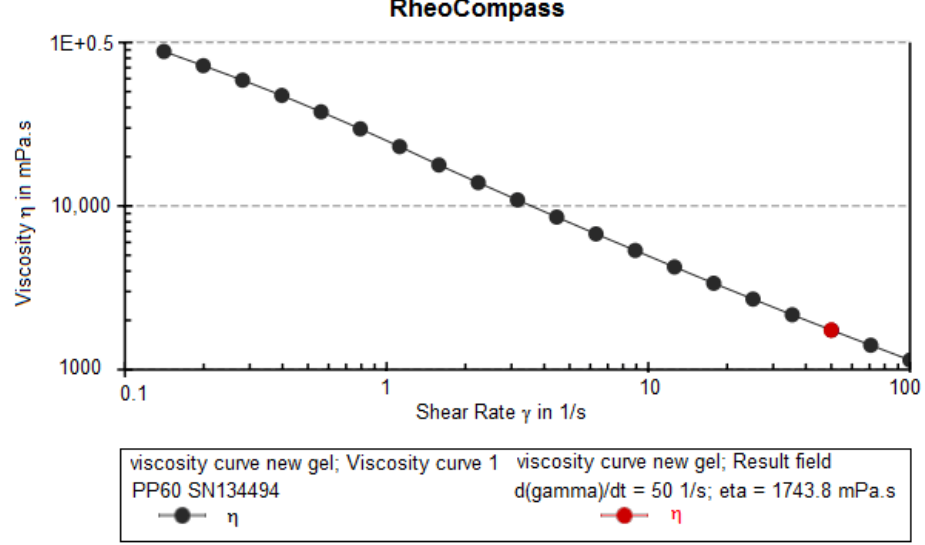
Figure 7. Viscosity vs. shear rate graph of QCT@NG.